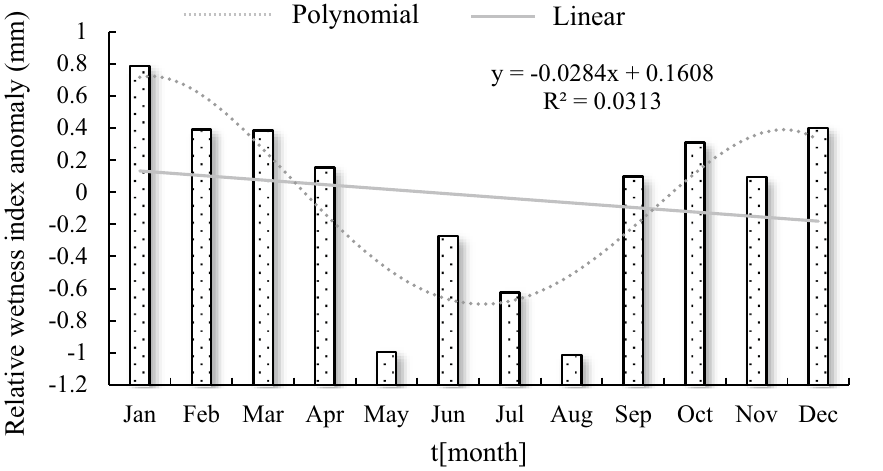
y = -0.0284x + 0.1608 R² = 0.0313